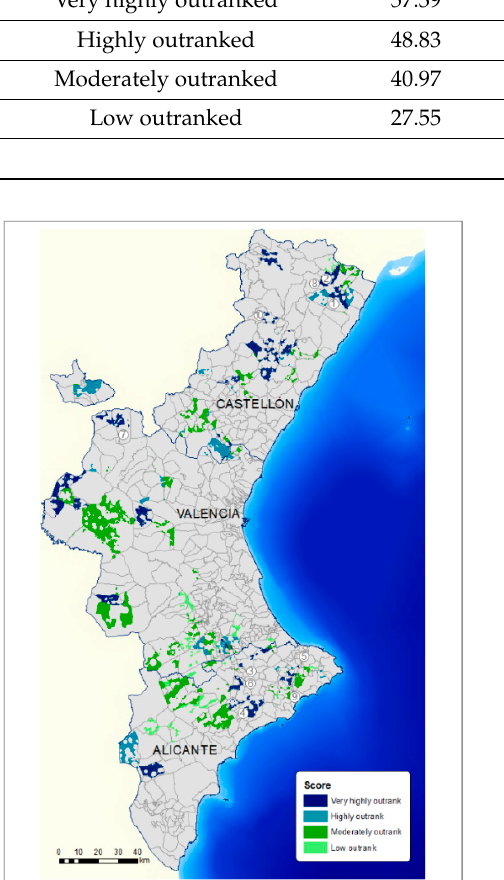
Figure 10. Map of the outranked municipalities depending on net flow value (the higher the score is the better the municipality).